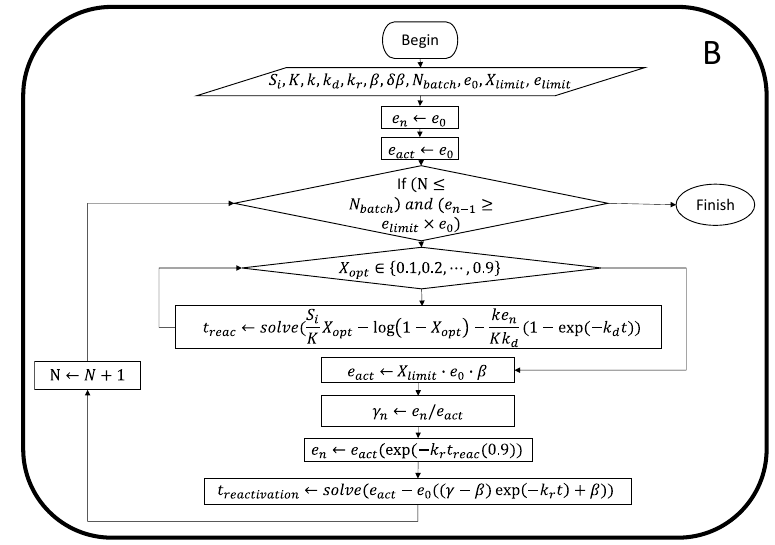
Figure 2. Simulation flow diagram: ( a ) without reactivation, ( b ) with reactivation.